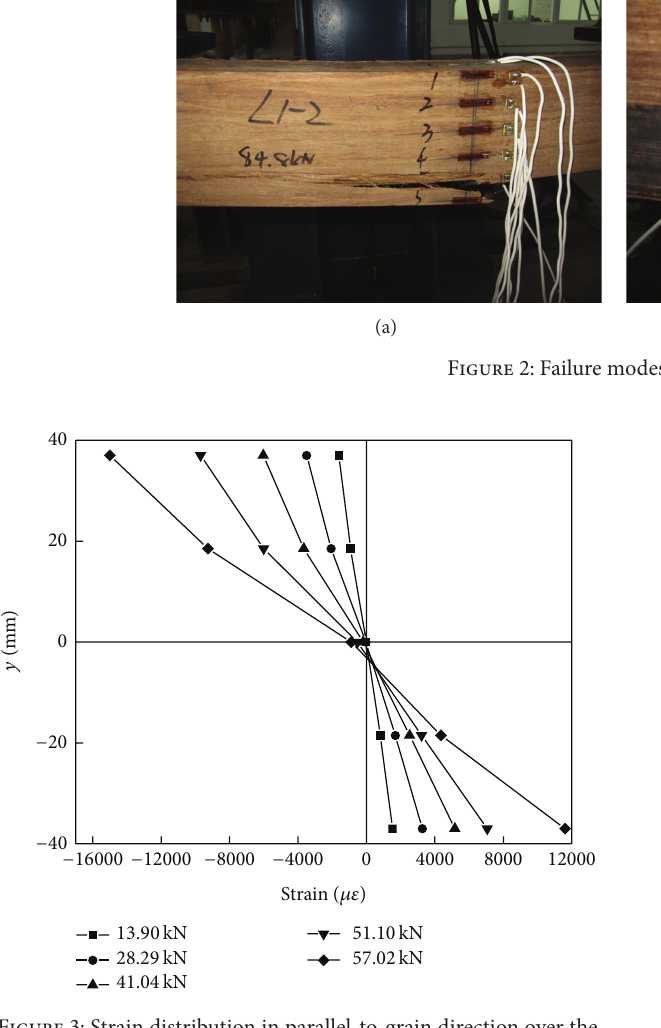
Figure 3: Strain distribution in parallel-to-grain direction over the depth of section.